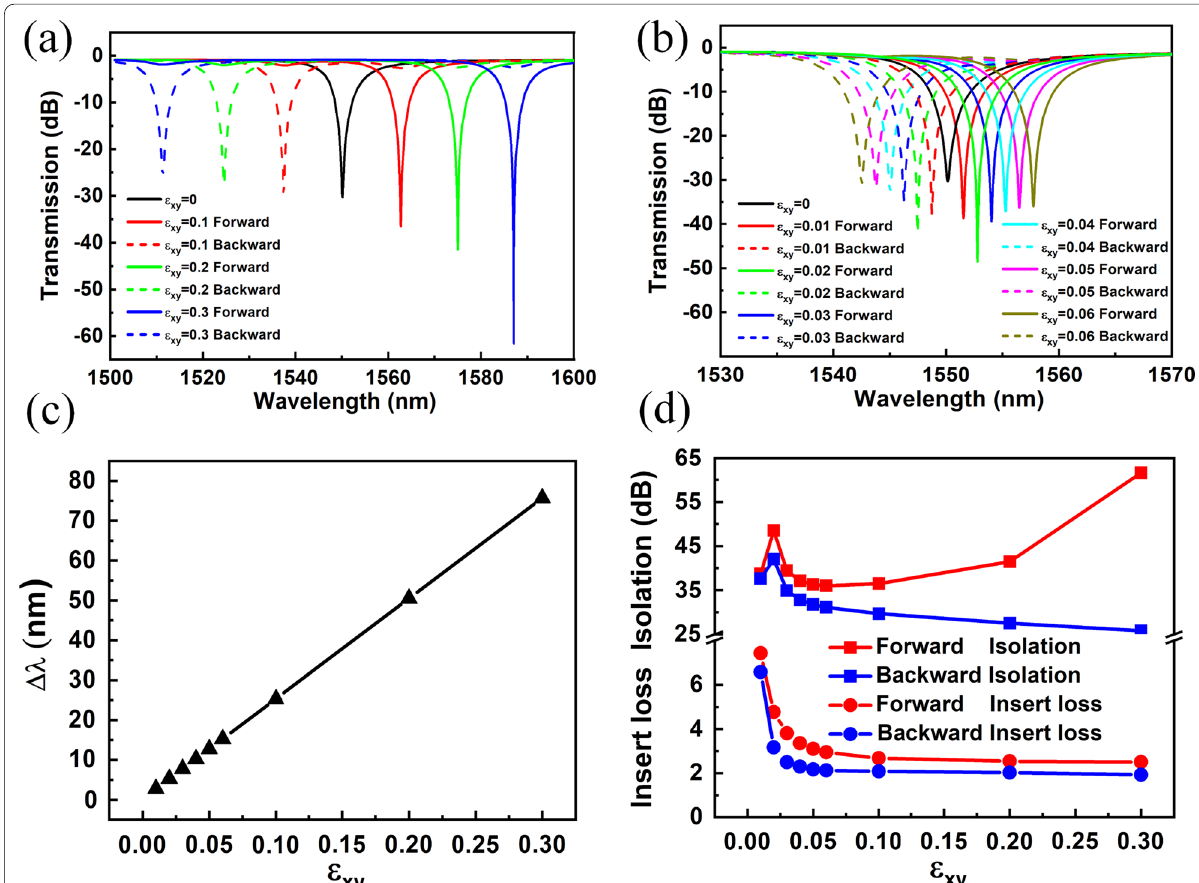
Fig. 3 The transmission spectra, wavelength splitting, IR and IL in mode TM 0,4 . a , b The transmission spectra of light from different propagation directions coupled into the disc cavity having different ε xy . c , d The linear graphs of wavelength splitting, IR, and IL as a function of ε xy